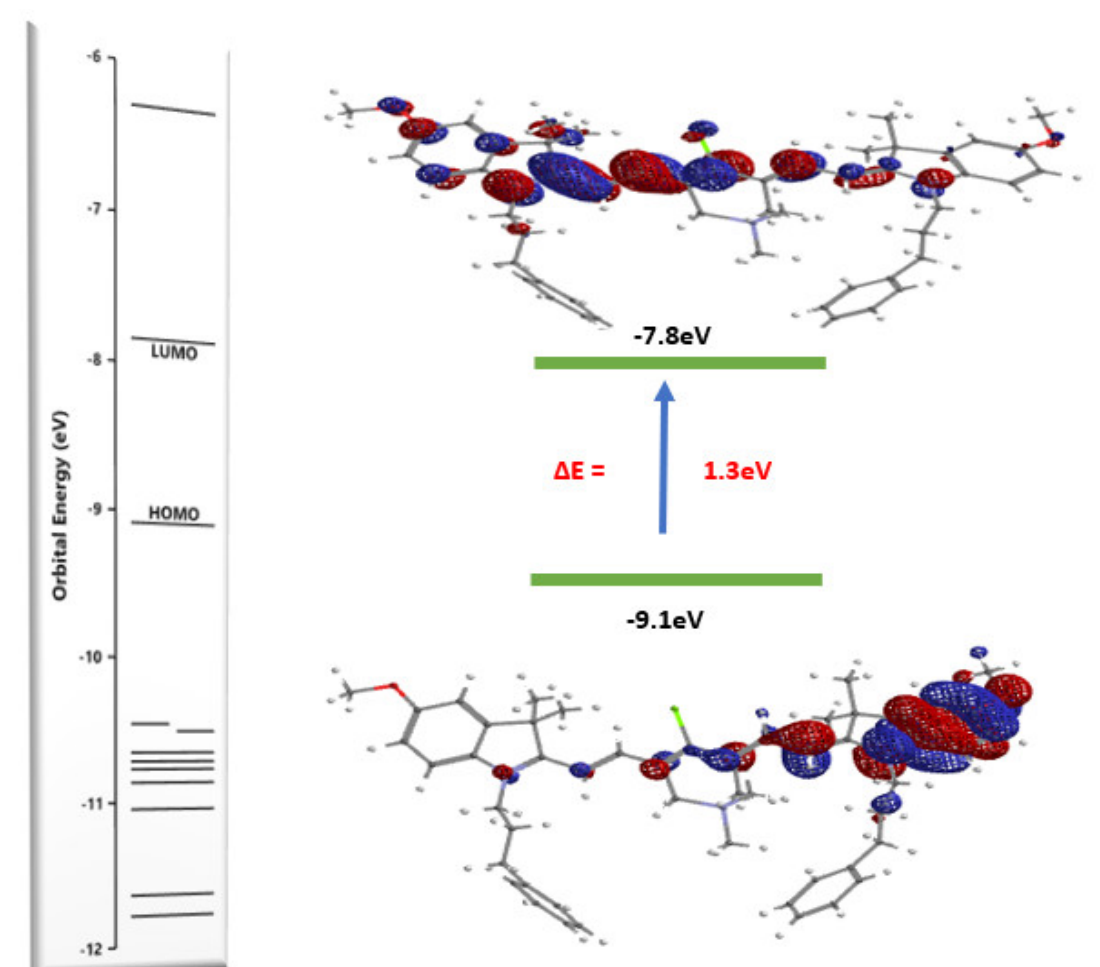
Figure 5. Theoretical calculations for the elucidation of the optical property of ERB-60 . Optimized molecular structure and frontier molecular orbitals for ERB-60 with its energy level and, S 0 –S 1 excitation energy based on DFT calculation at the B3LYP/6-311 G(d,p) level.